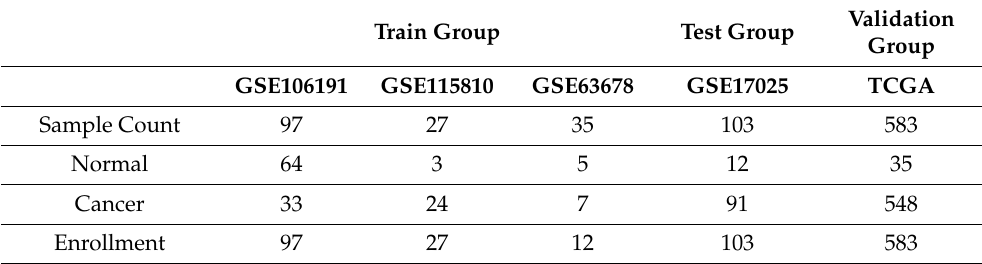
Table 1. Composition of the datasets and component of patients enrolled in this study. Train Group Test